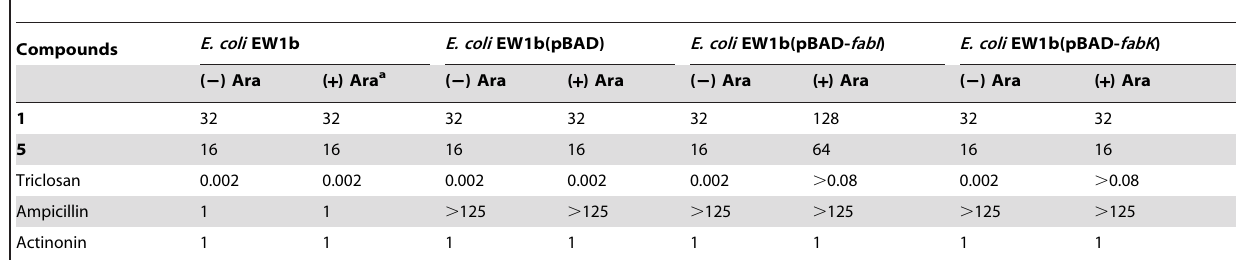
Table 5. Unchanged susceptibility of fabK -overexpressing E. coli to meleagrin ( 1 ) and its derivative (MIC, m g/mL).